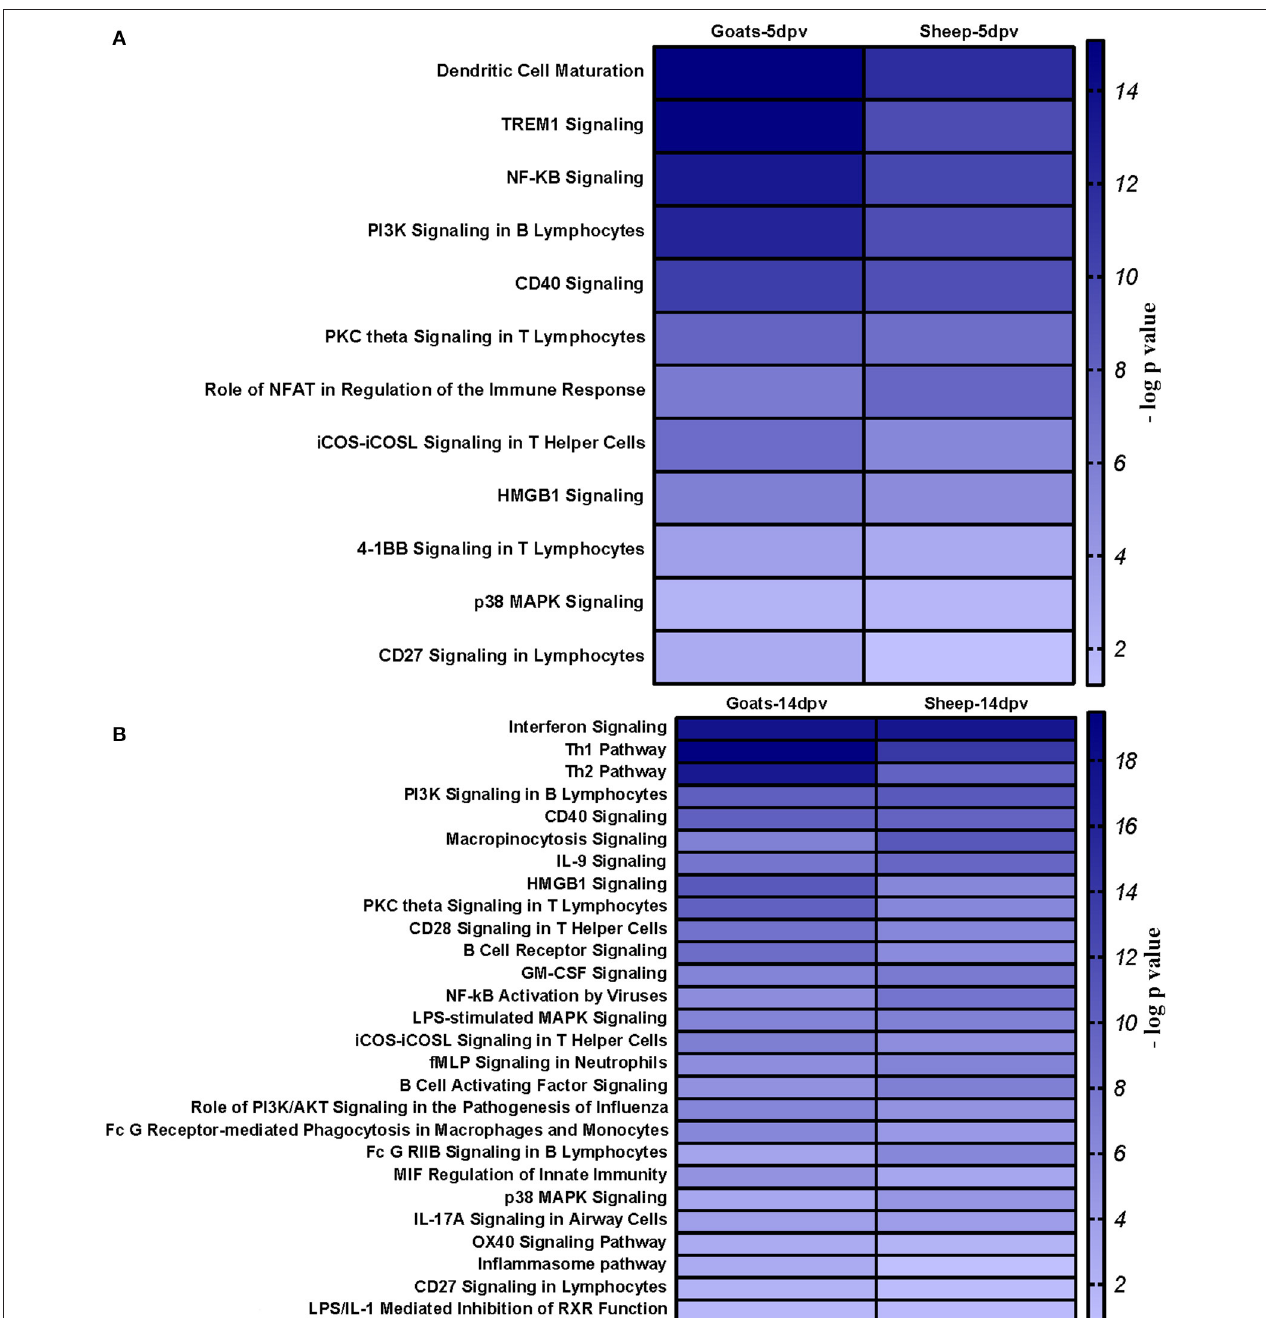
FIGURE 7 | Comparison analysis of canonical pathways significantly enriched in vaccinated goats and sheep at (A) 5 days post-vaccination (dpv) and (B) 14 dpv generated in the Ingenuity Pathway Analysis tool.